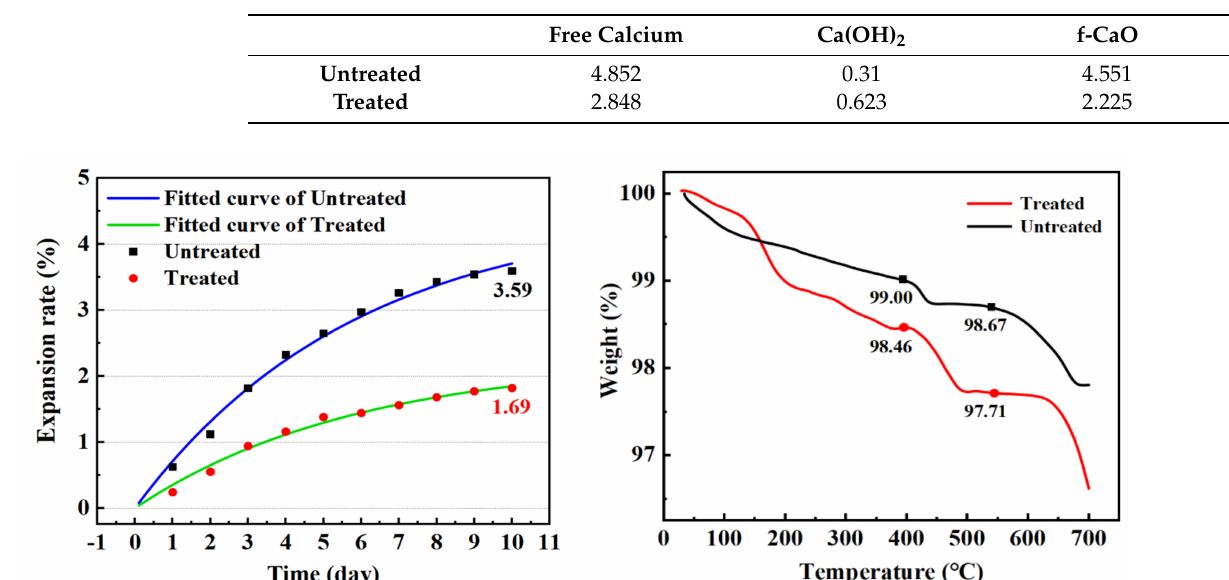
Table 7. Comparison of f-CaO content (Wt.%).